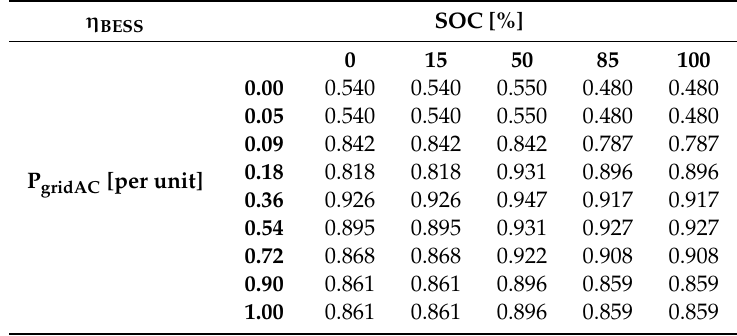
Table 7. BESS e ffi ciency lookup table as implemented in the